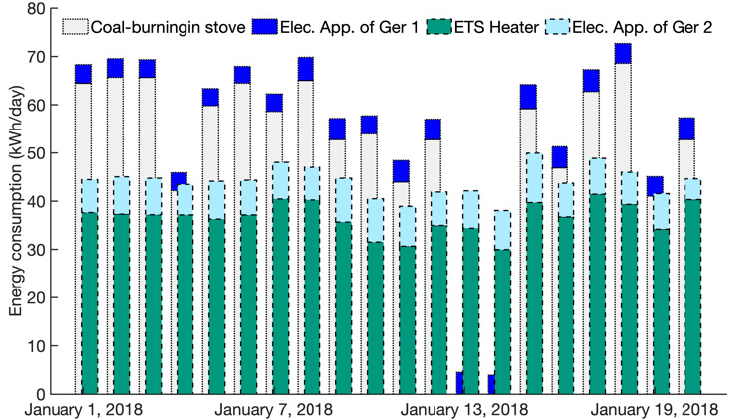
Figure 5. Daily energy performance of Ger 1 and 2 on the annually coldest day of the year. The grey- and blue-colored bars indicate the daily heating consumption and electricity consumption of the electric appliances of Ger 1, and the daily energy consumption of Ger 2 is presented by green- and aqua-colored bars for the ETS heater and electric appliances.